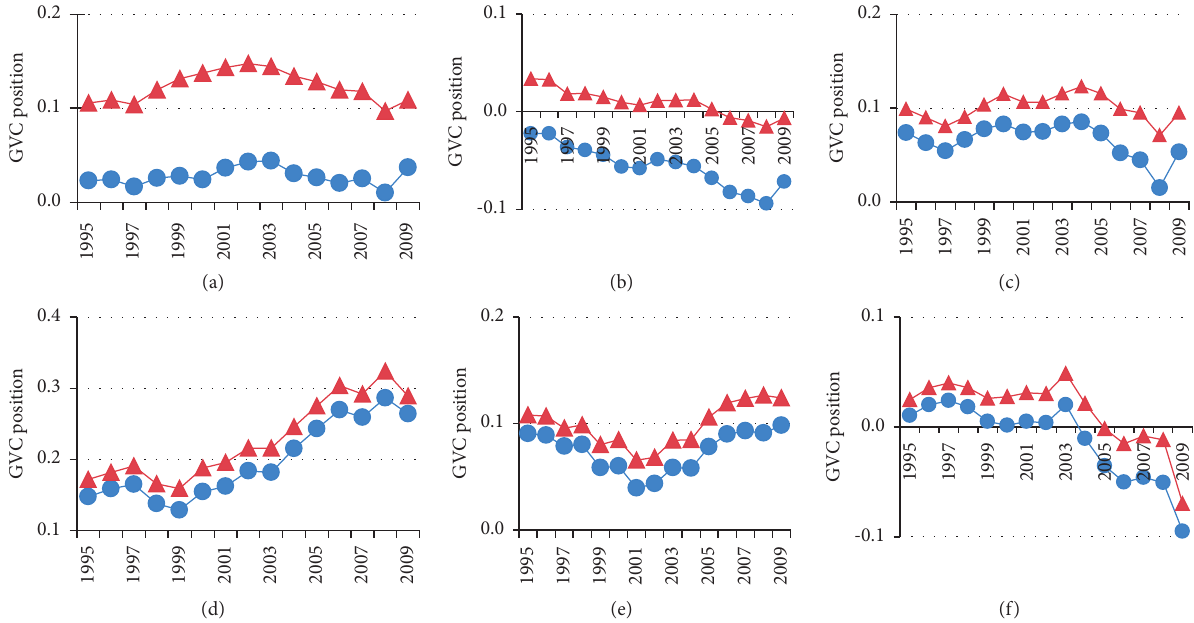
Figure 2: Major countries’ GVC position over the period of 1995–2009. Note . The blue line is the GVC position before the improvement, and the red line is the GVC position after the improvement. (a) USA. (b) Germany. (c) Japan. (d) Russia. (e) Brazil. (f) India.